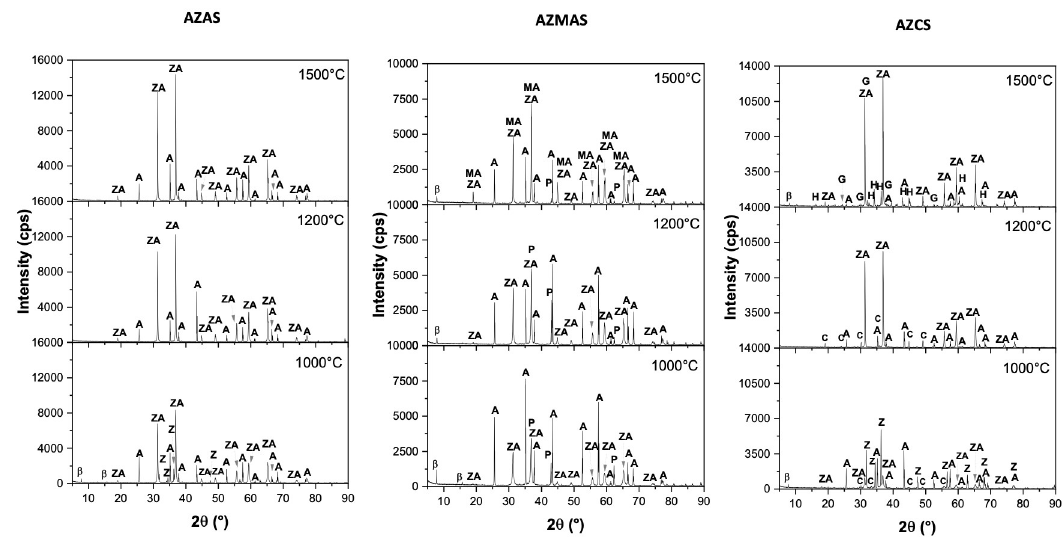
Figure 3. XRD profiles of the matrix samples (d < 200 μm) of the evaluated castables after firing at 1000, 1200 and 1500°C for 5h. XRD JCPDS cards: A